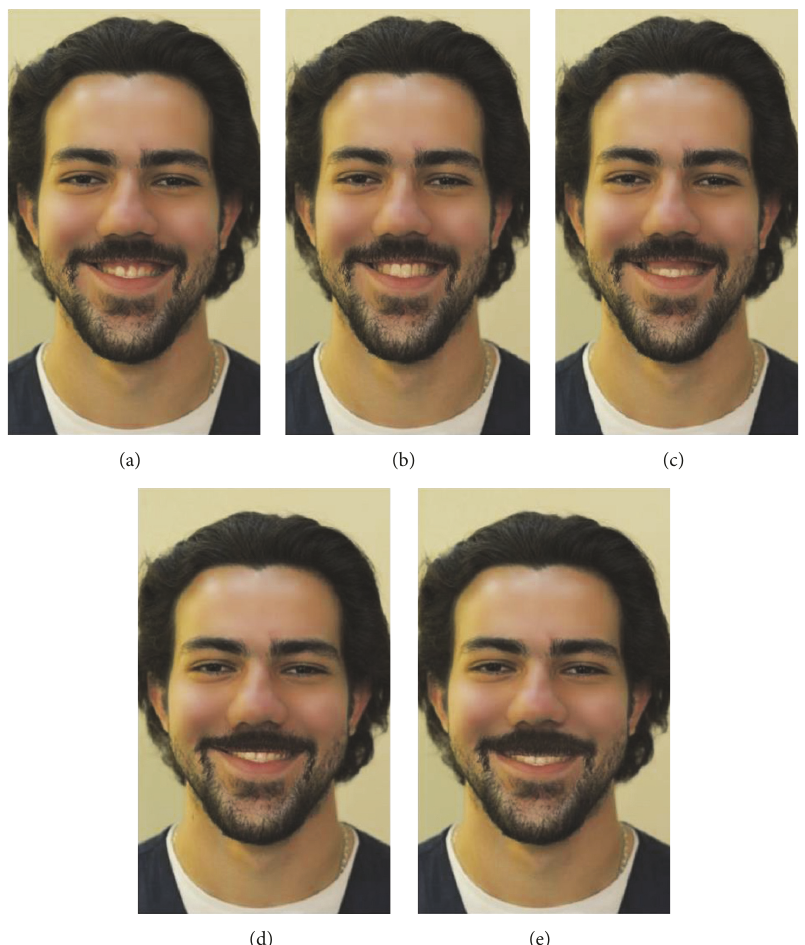
Figure 2: Long face smiles. (a) Long face +2mm; (b) long face 0mm; (c) long face +4 mm; (d) long face − 2 mm; (e) long face − 4mm.